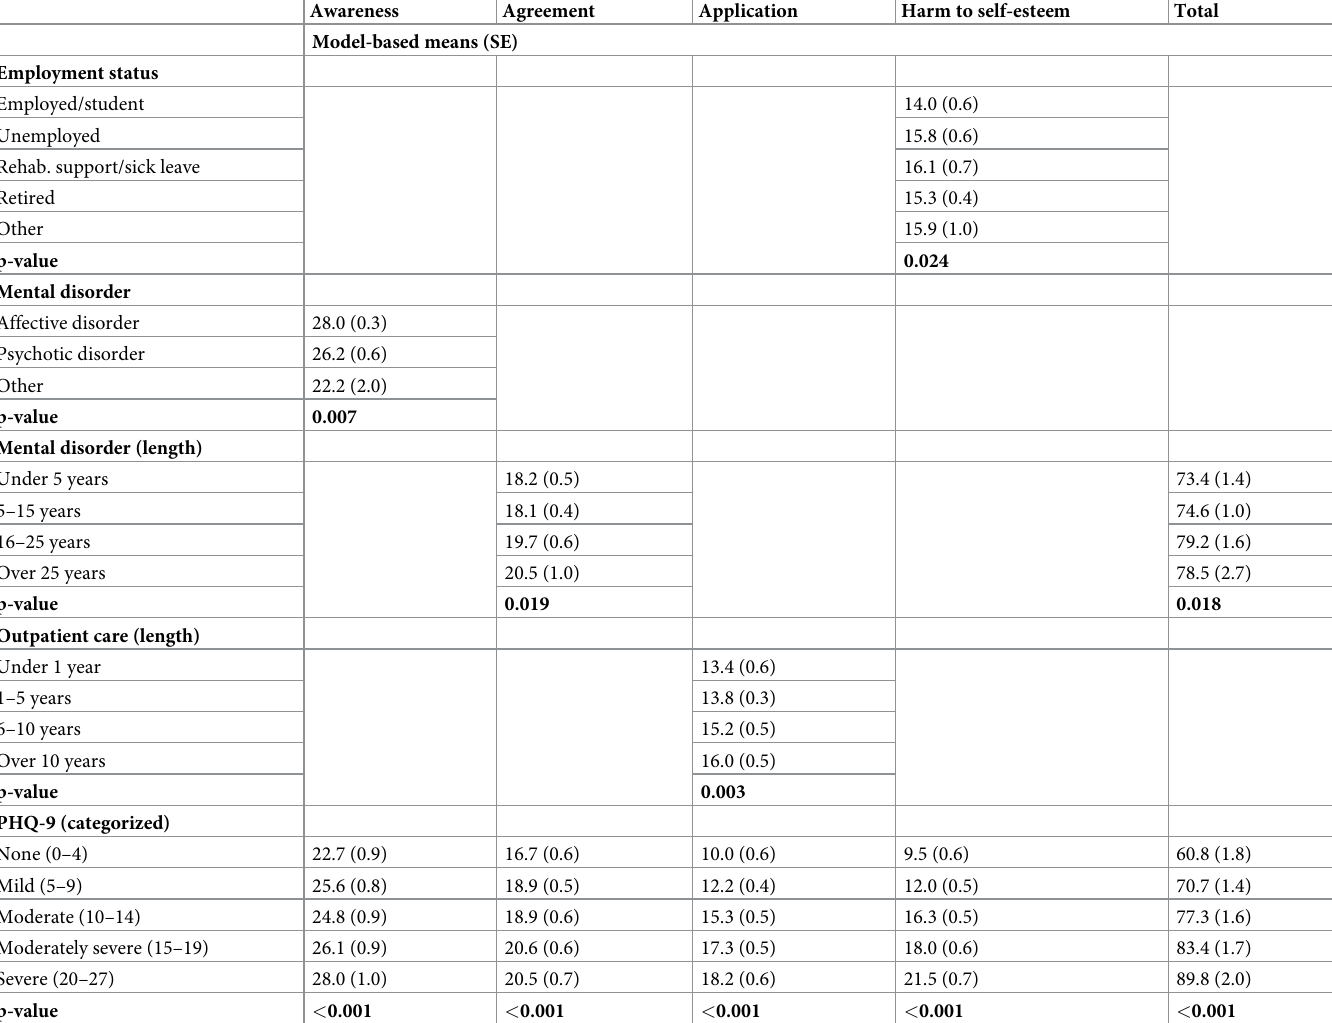
Table 4. Final multivariable model for self-stigma of Mental Illness Scale and all subscales. All significant explanatory variables from univariate modelling were first included and then non-significant terms were removed.